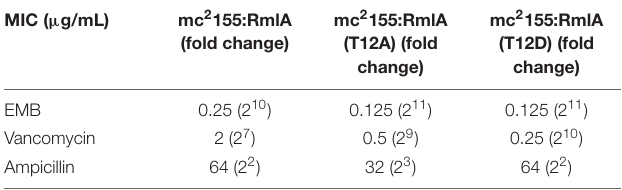
TABLE 2 | MICs of RmlA mutants to